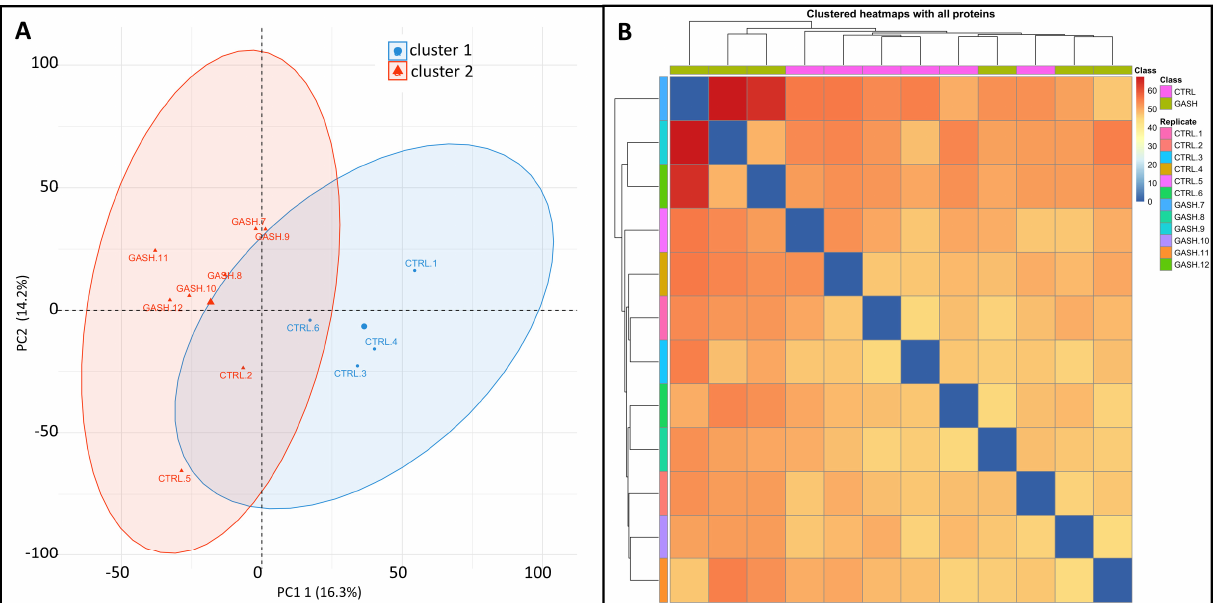
Figure 2. Principal Component Analysis (PCA) and clustering with all proteins. ( A ) Scatter plot of PCA of protein quantitative values from each sample in each group. k-means clustering PCA. The X -axis is the first principal component, and the Y -axis is the second principal component. ( B ) HeatMap of sample correlation analysis. Both X and Y axes represent samples. The color represents the correlation coefficient (the red color represents the higher correlation; the blue color represents the lower correlation).